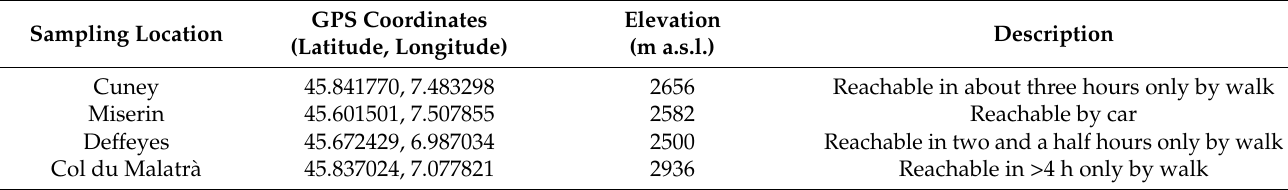
Figure 1. Map of the sampling area (Aosta Valley, Western Italian Alps). Red dots indicate the sampling locations. Table 1. Characteristics of the four sampling locations were snow samples were